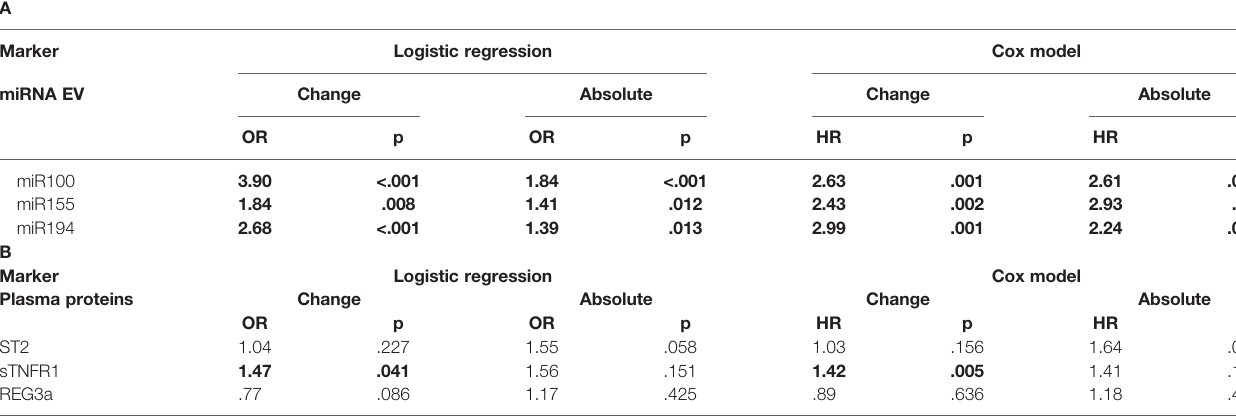
TABLE 3 | Association between acute GvHD and EV-derived miRNAs and plasmatic biomarker levels. A Marker Logistic